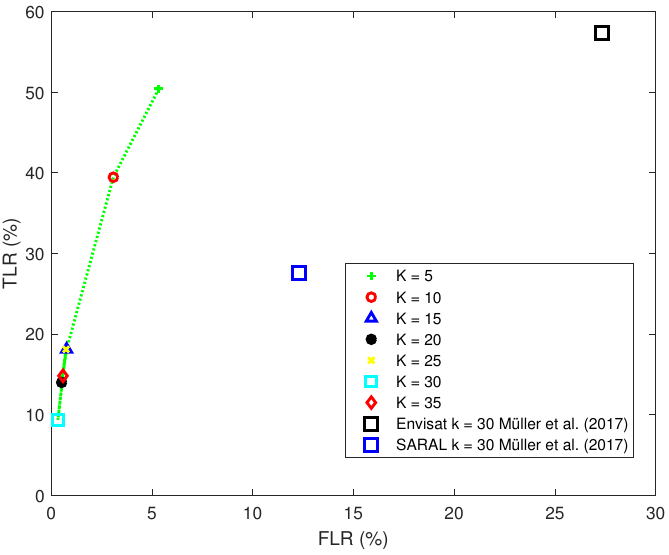
Figure 4. ROC graph depicting the change in performance for different cluster sizes. The performances calculated from the study from Müller et al. [11] are also